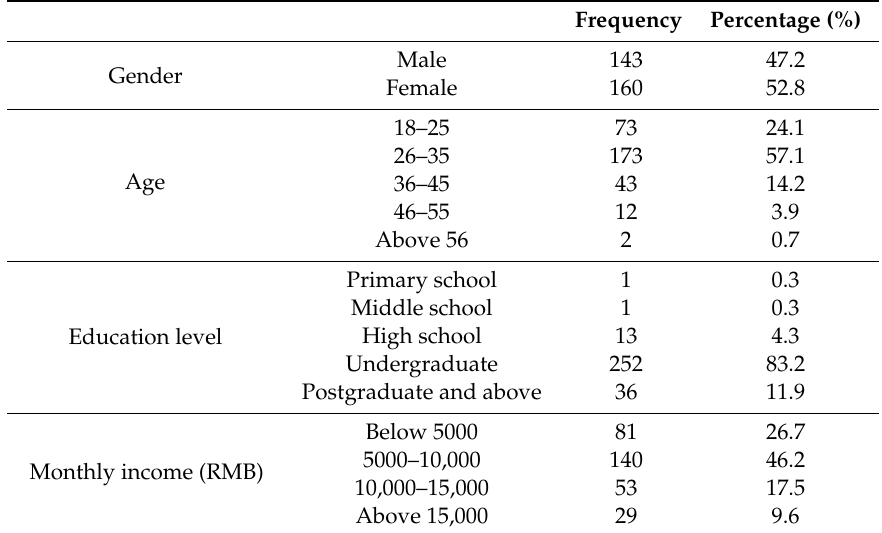
Table 2. Respondents’ demographic information ( N =